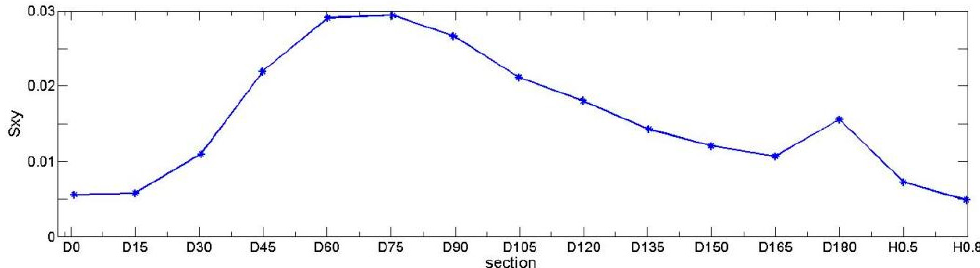
Figure 10. The distributions of circulation strength along the curve.